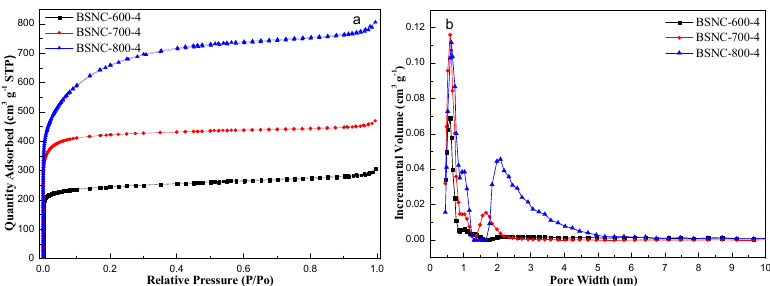
Figure 2. ( a ) Nitrogen adsorption / desorption isotherms and ( b ) pore size distribution of BSNC-600-4, BSNC-700-4 and BSNC-800-4. Table 1. Porosity properties and chemical composition of Table 1. Porosity properties and chemical composition of BSNCs.